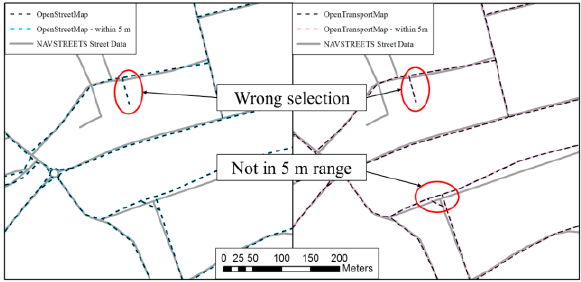
Figure 2: Selection errors applying the “within a distance of 5m” criteria.